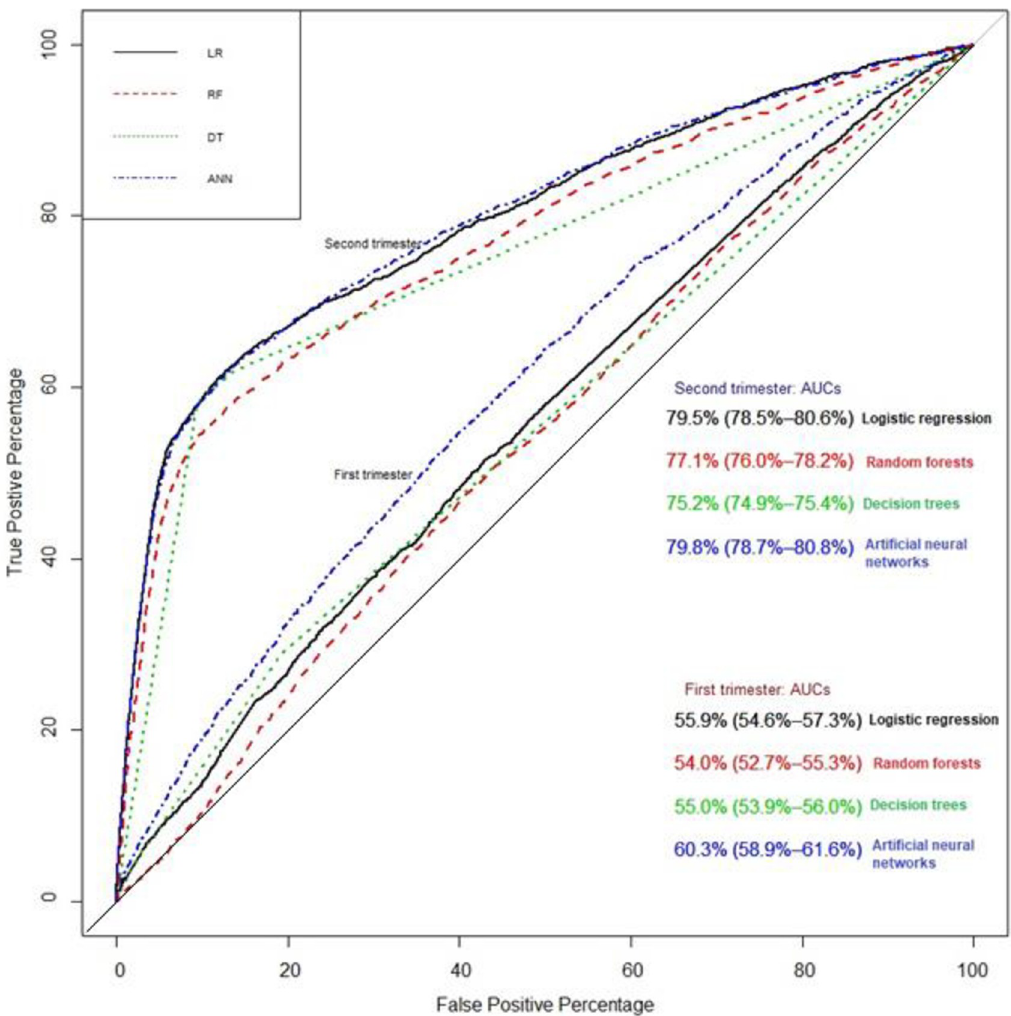
Fig 3. Comparison of prediction models during the first and second trimester for preterm birth in nulliparous women.